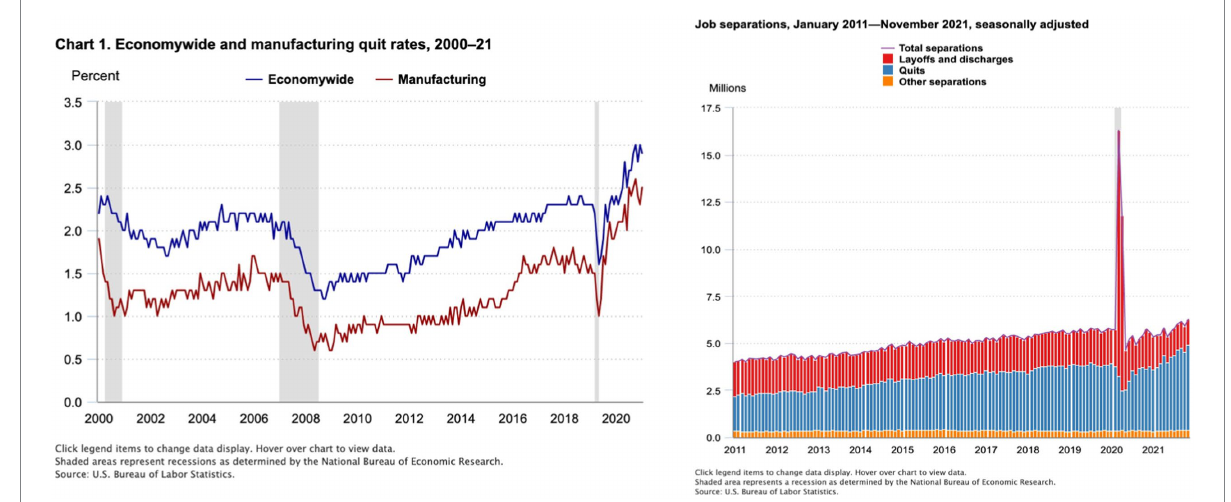
FIGURE 1 Economywide and manufacturing quit rates. Represents the highest voluntary separation rate (quits) in 2021. In November 2021, quits increased in several industries, with the largest increases in accommodation and food services; health care and social assistance; and transportation, warehousing, and utilities (The Bureau of Labor Statistics,